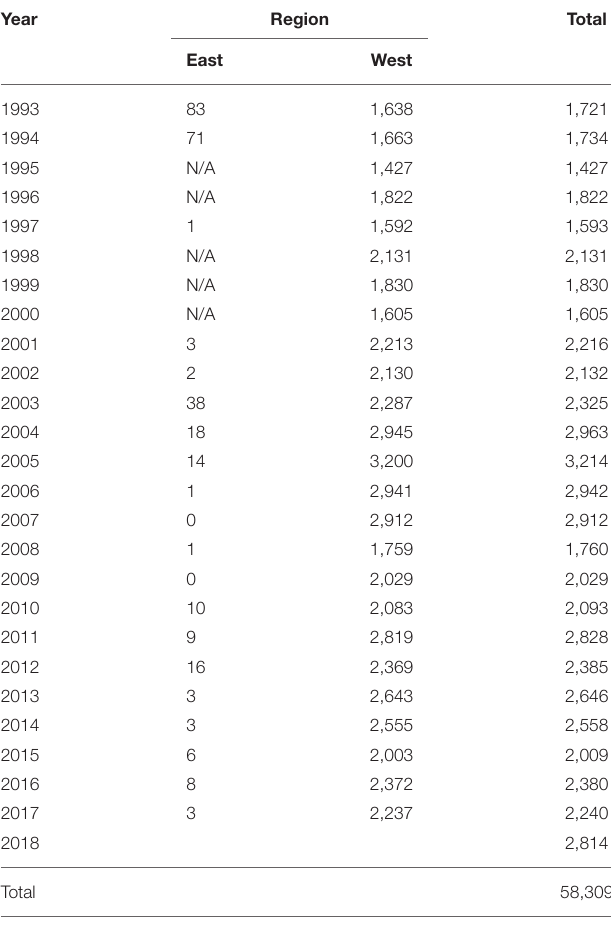
TABLE 3 | Harbor porpoise take in Greenland 1993–2018 (Adapted from NAMMCO catch database 7